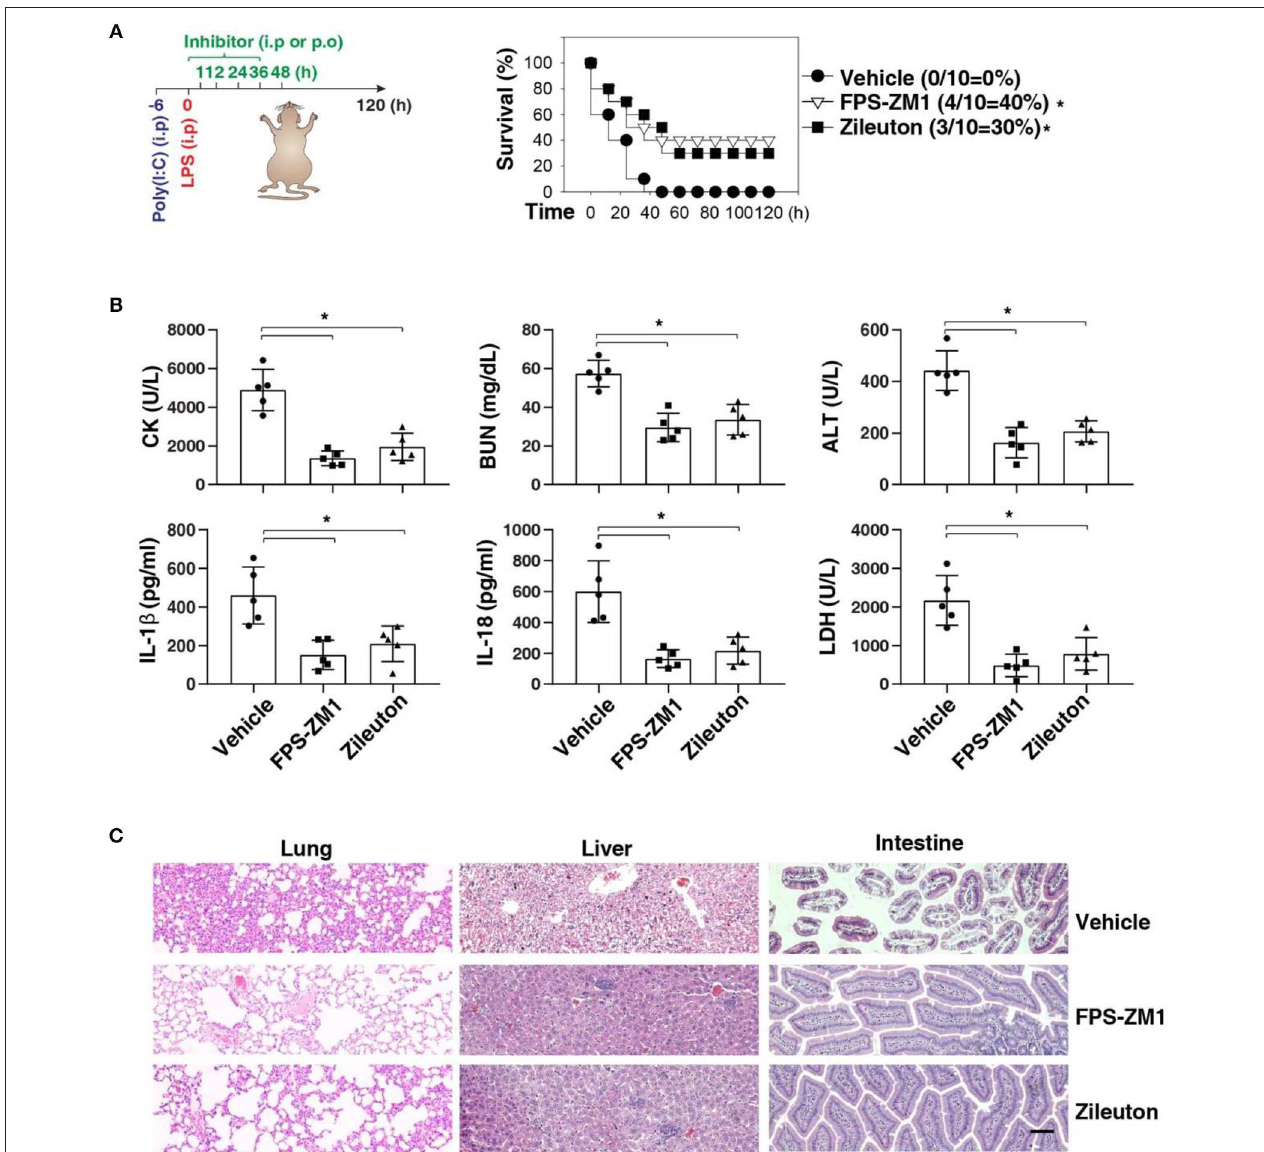
FIGURE 7 | Delayed administration of FPS-ZM1 and zileuton protects against septic shock. (A) Survival of indicated mice primed with poly(I:C) (10 mg/kg, i.p.) and then challenged 6h later with LPS (2 mg/kg, i.p.) in the absence or presence of the administration of FPS-ZM1 (10 mg/kg, i.p.) or zileuton (30 mg/kg, p.o.) at + 1, + 12, + 24, + 36, and + 48h. n = 10 mice/group, * P < 0.05, Kaplan-Meier survival analysis. (B,C) In parallel to panel A, quantitation of indicated serum markers (B) or hematoxylin/eosin staining of indicated tissues (C) in poly(I:C)-primed mice challenged with LPS at + 3h (bar = 100 µ M). n = 5 mice/group, * P < 0.05, ANOVA LSD test. Animal data represent two independent